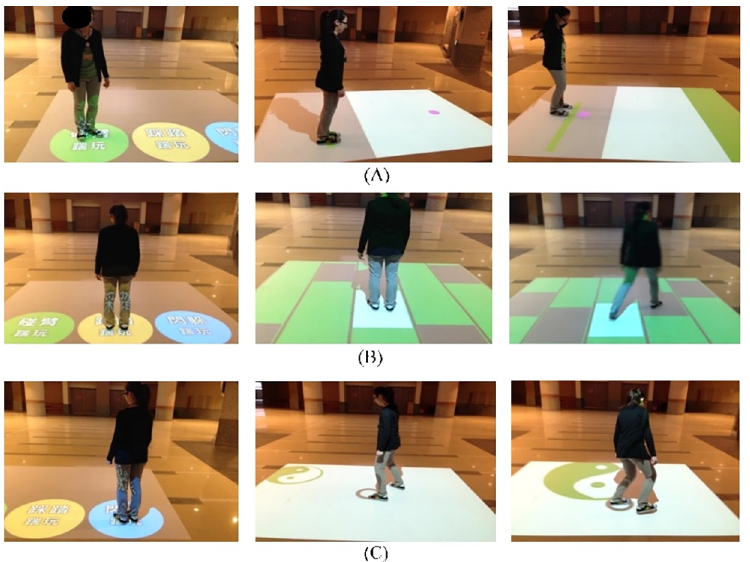
Fig 2. Interactive Floor Kick and Play. Three different game modes are supported: (A) Touch Arm Kick Play, (B) Stampede Kick Play, and (C) Dodging Kick Play.